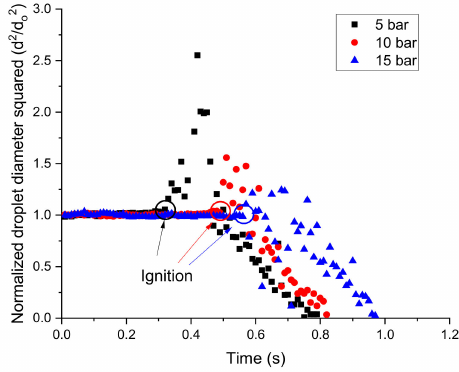
Figure 14. Temporal variation of normalized droplet diameter squared at 700 ◦ C.